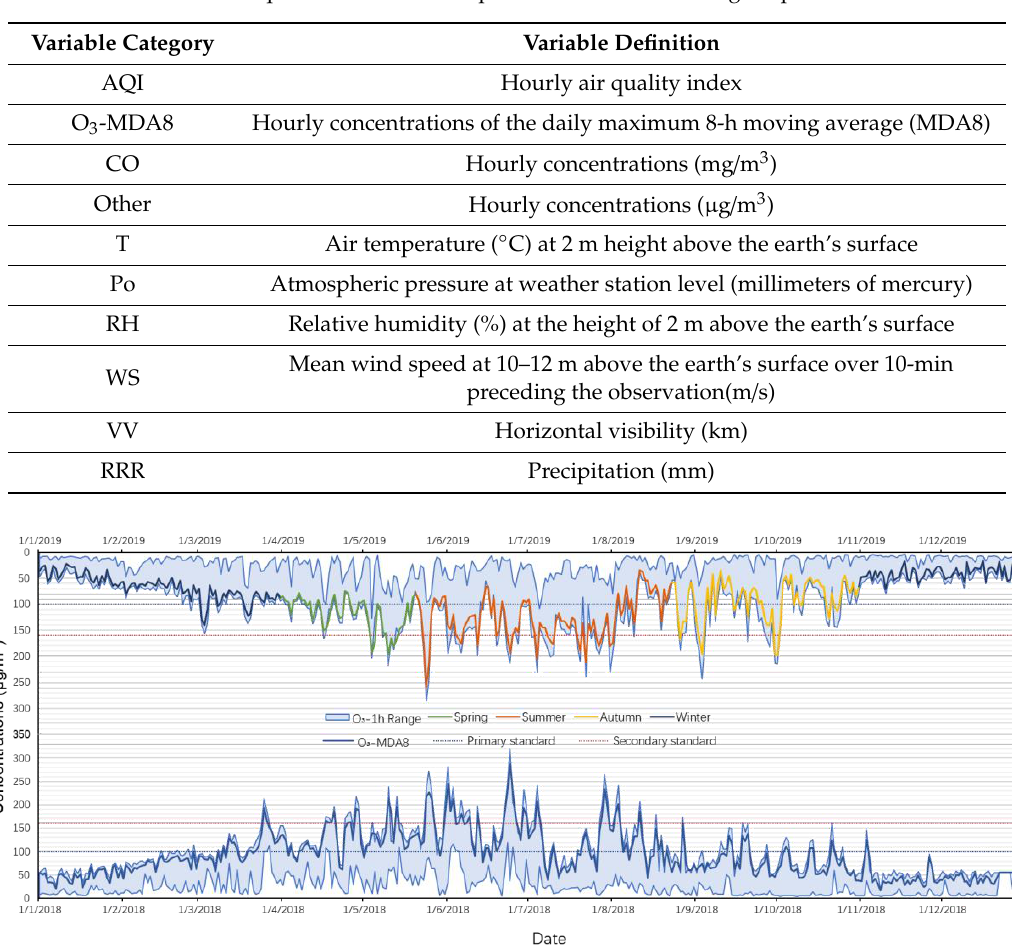
Figure A1. Daily variation of O 3 -1 h extreme range and O 3 -MDA8 2018–2019. Note: data missing from 22 to 26 December 2018 (replaced by average).